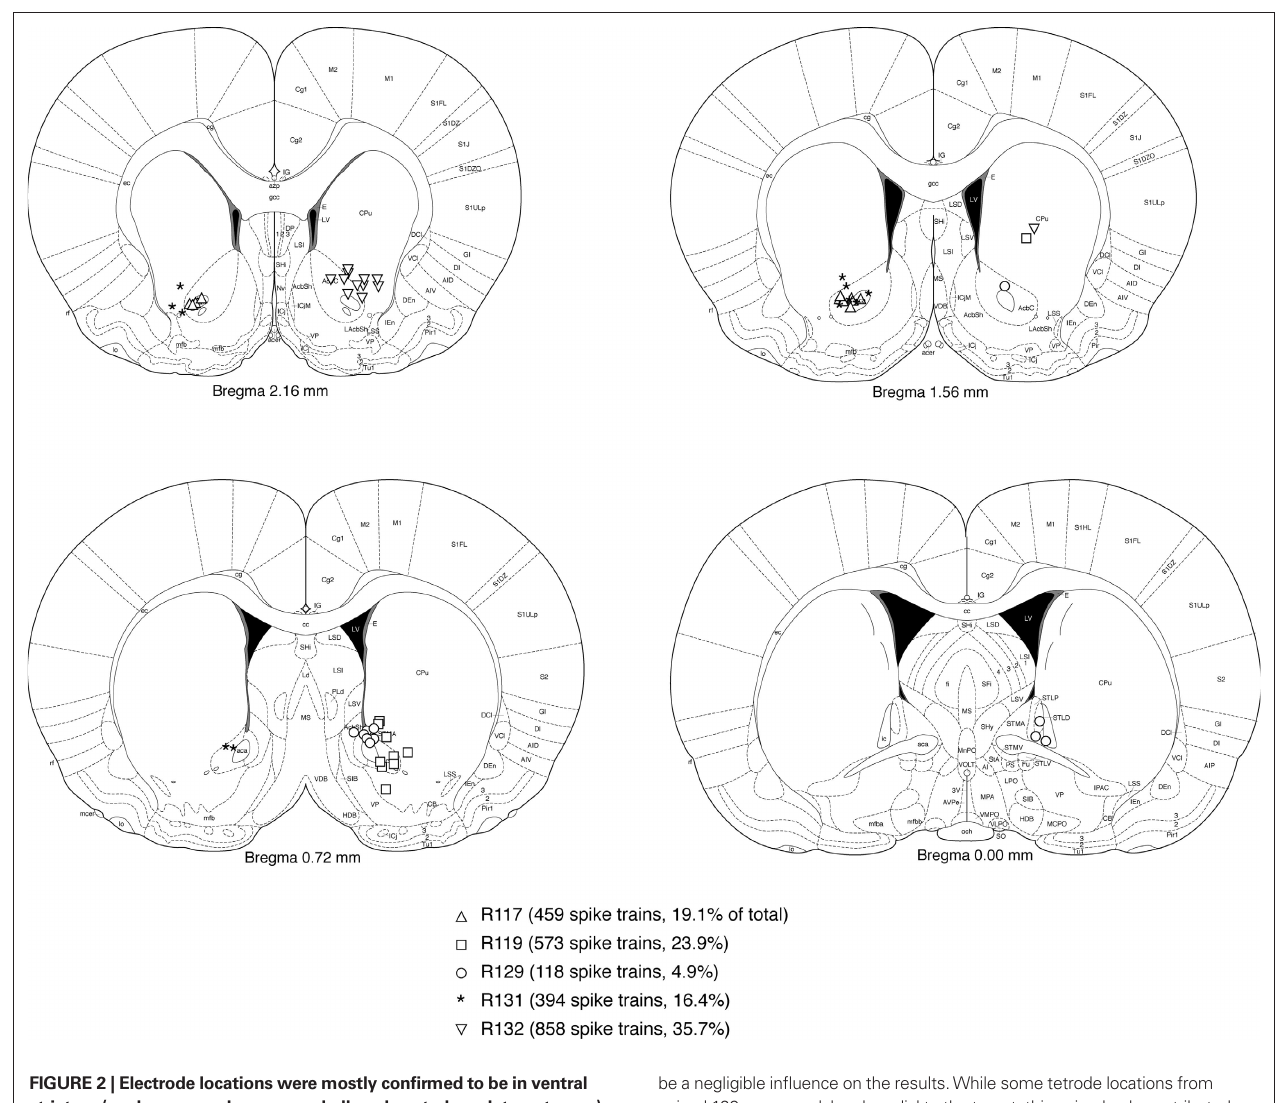
be a negligible infl uence on the results. While some tetrode locations from animal 129 were caudal and medial to the target, this animal only contributed a relatively small proportion of cells to the data set. Based on these considerations, we estimate that at least 90% of spike trains were recorded from ventral